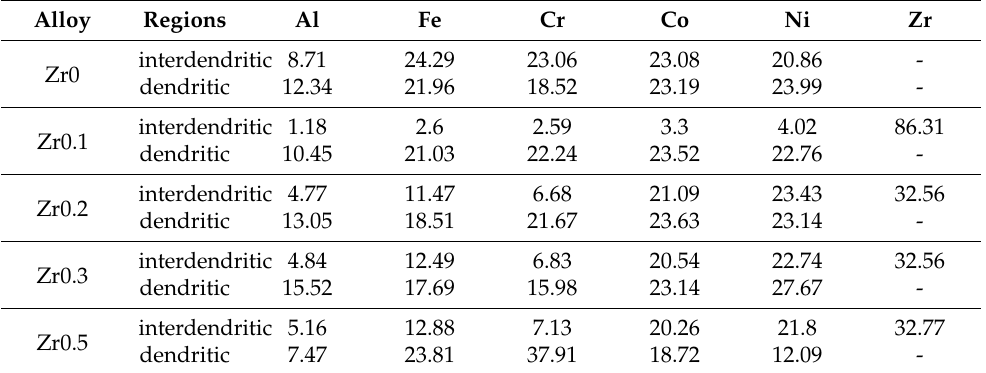
Table 2. EDS results of the dendritic and interdendritic zones of AlCoCrFeNiZr x alloys (wt %). Alloy Regions